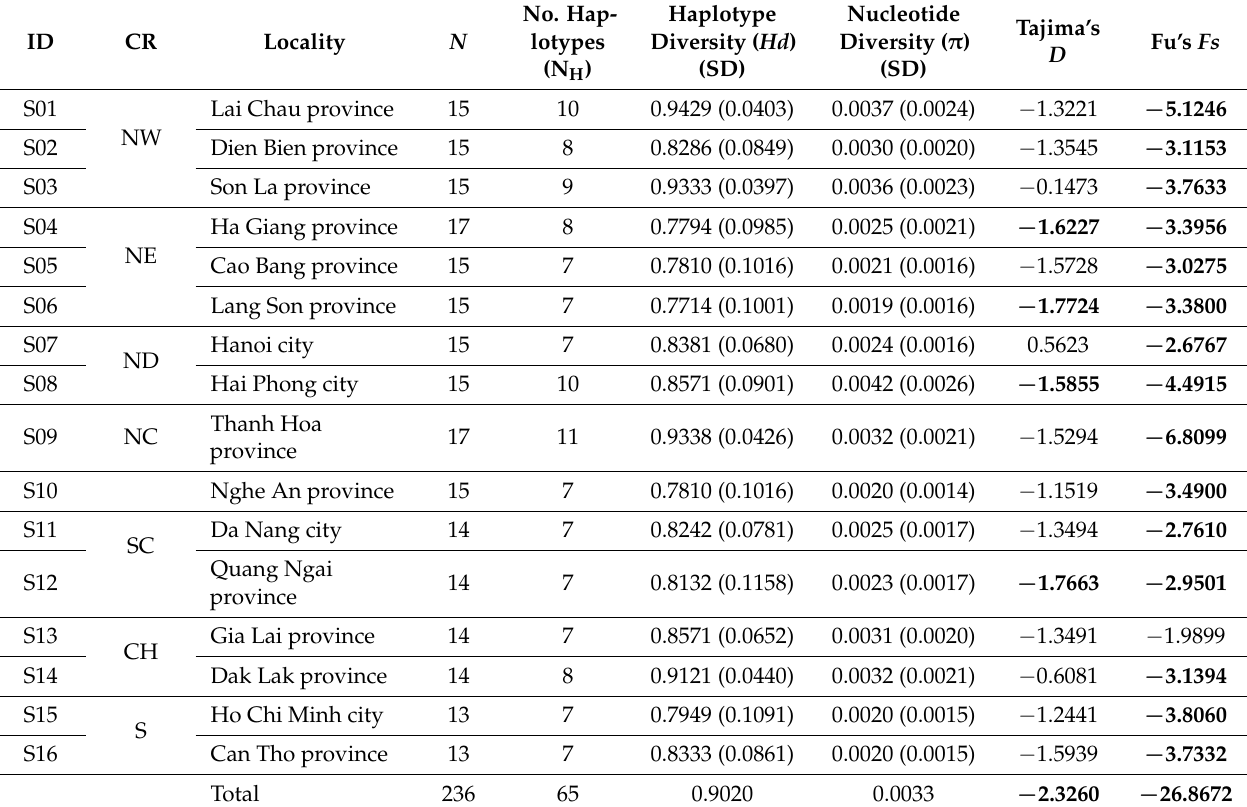
Table 1. Location and genetic diversity of Aedes albopictus populations in